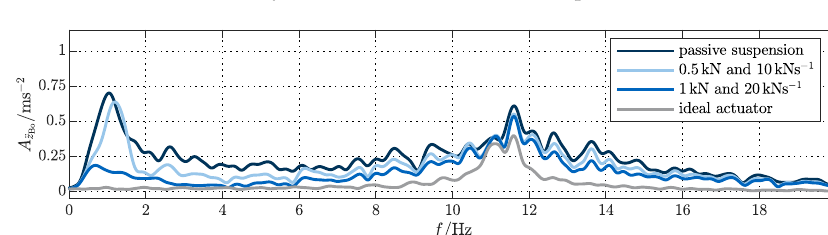
Figure A9. FFT of dynamic wheel-load for the AB profile at 180kmh − 1 .